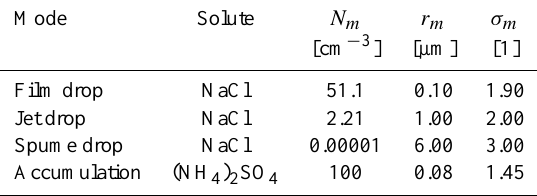
Table 1. Aerosol distributions used in the example model run